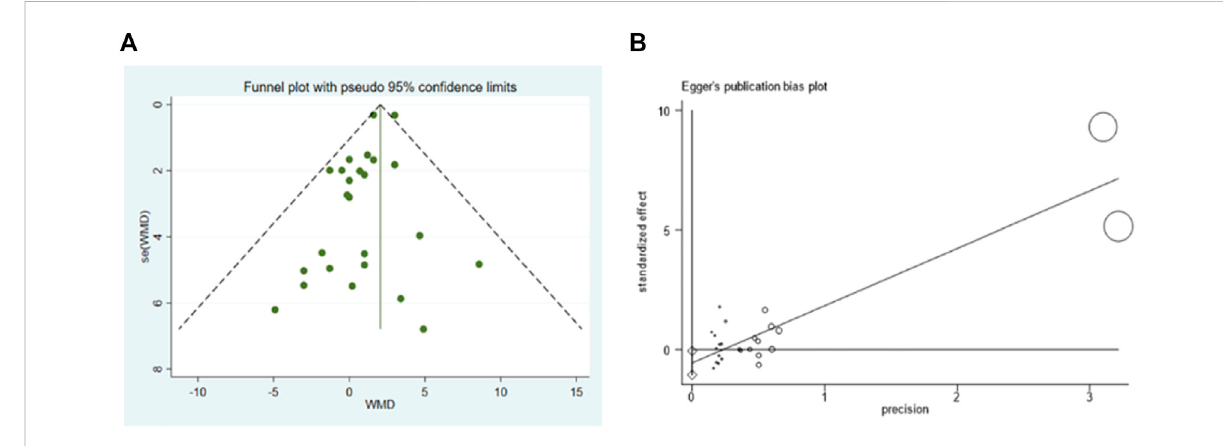
FIGURE 10 Publication bias. (A) , funnel plot; (B) , egger test ( p >